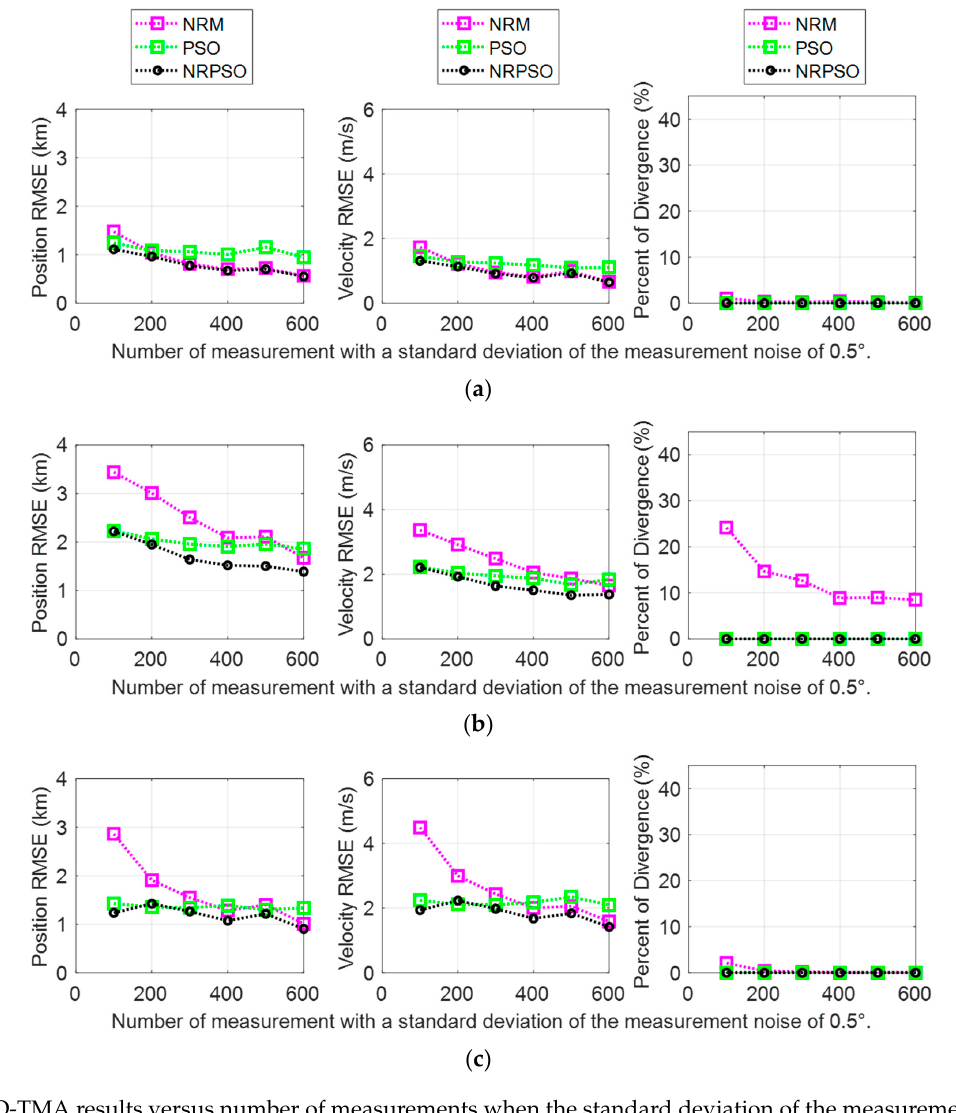
Figure 5. BO-TMA results versus number of measurements when the standard deviation of the measurement noise was 0.5° for ( a ) Target 1, ( b ) Target 2, and ( c ) Target 3. The results of NRM, PSO, and NRPSO are represented by magenta, green, and black, respectively. The left column shows the position RMSE, the center column shows the velocity RMSE, and the right column shows the rate of divergence.